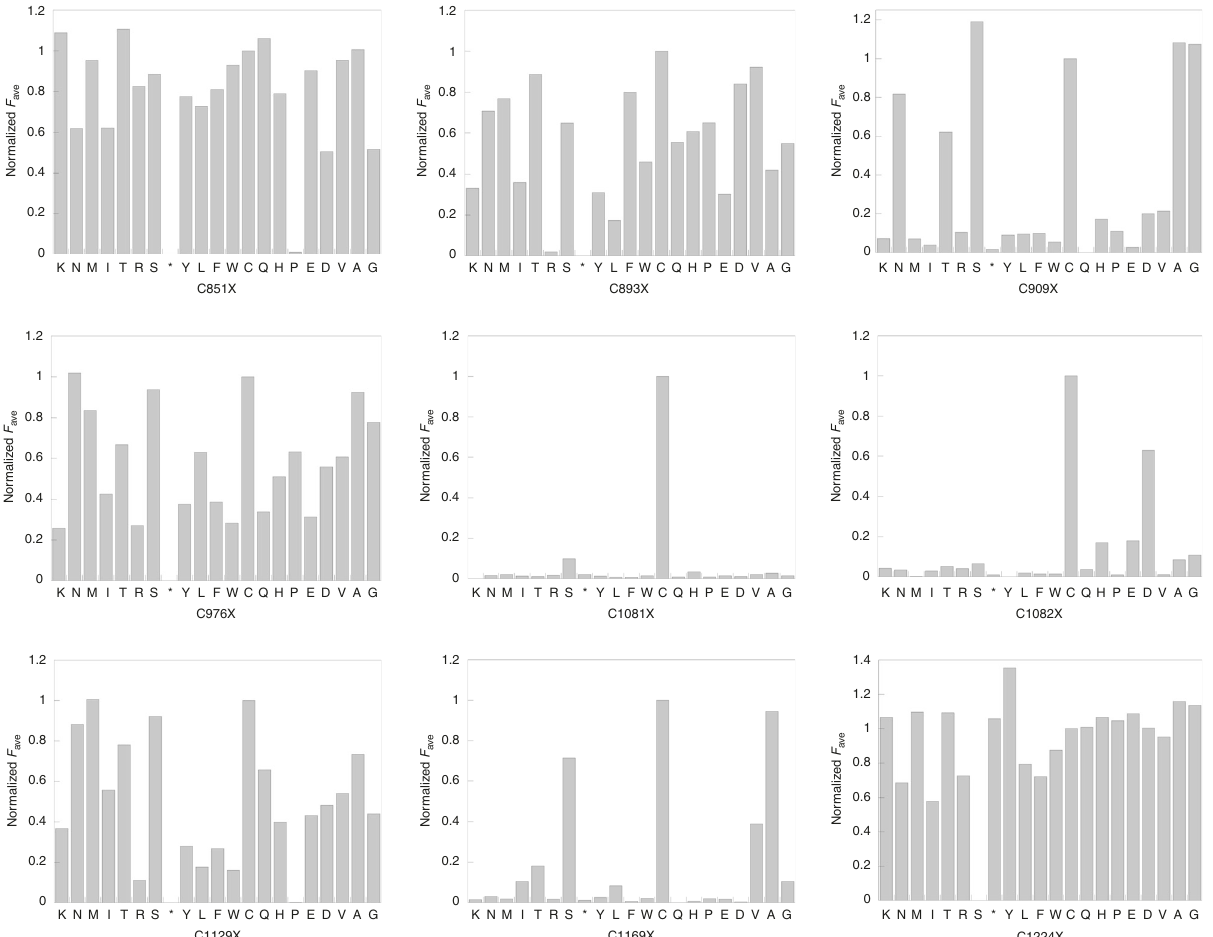
Fig. 2 Normalized averaged fl uorescence (Normalized F ave ) corresponding to each of 20 amino acids at nine different cysteine residues within hADAR1 catalytic domain. Asterisk indicates stop